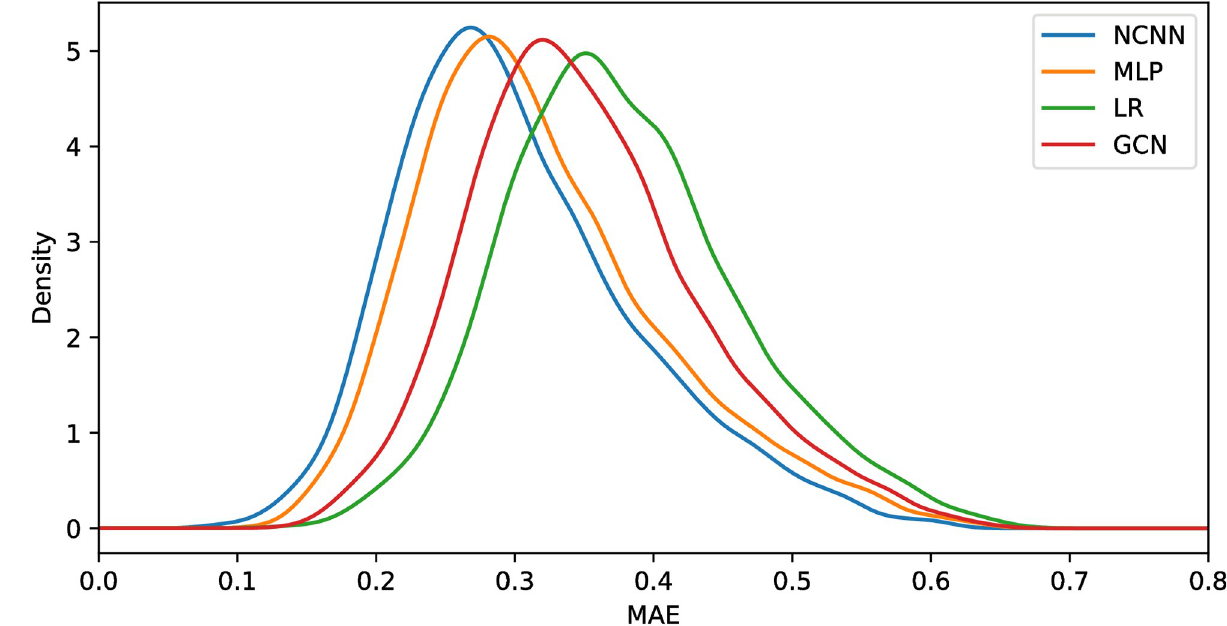
Fig 3. Density plot of different models with the best